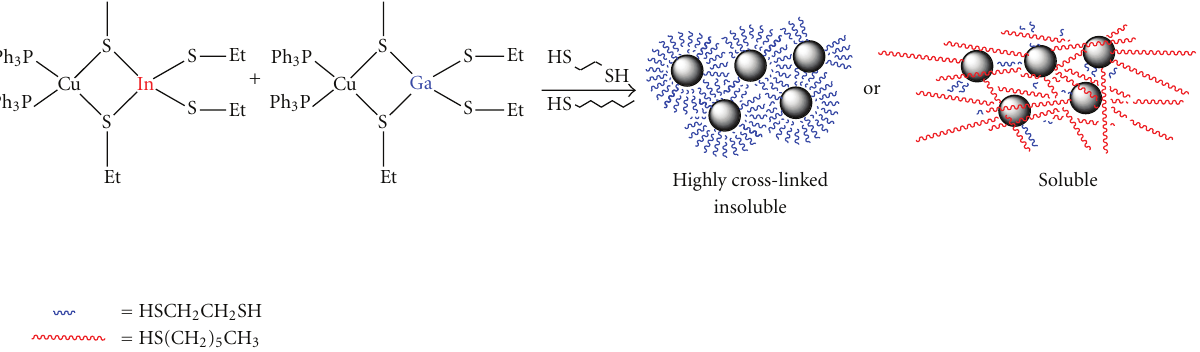
Figure 2: Formation of soluble and insoluble CIGS nanoparticles from SSPs by controlling the ratio between 1,2-ethanedithiol and 1-